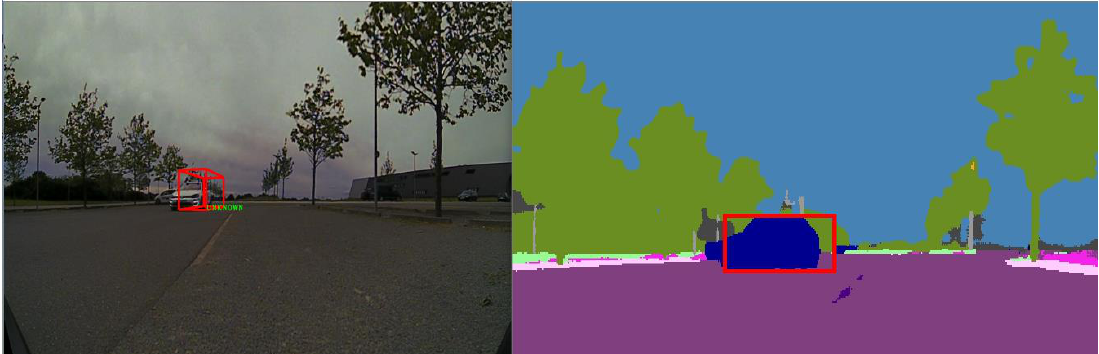
Figure 18. Example of mismatch in the validation procedure. On the left-hand side, we observe the projected fused object on the RGB image with the semantic class UNKNOWN. In the right image, the same object is projected onto the semantic class image in a region with the dominant class car. The class mismatch is represented using red color.